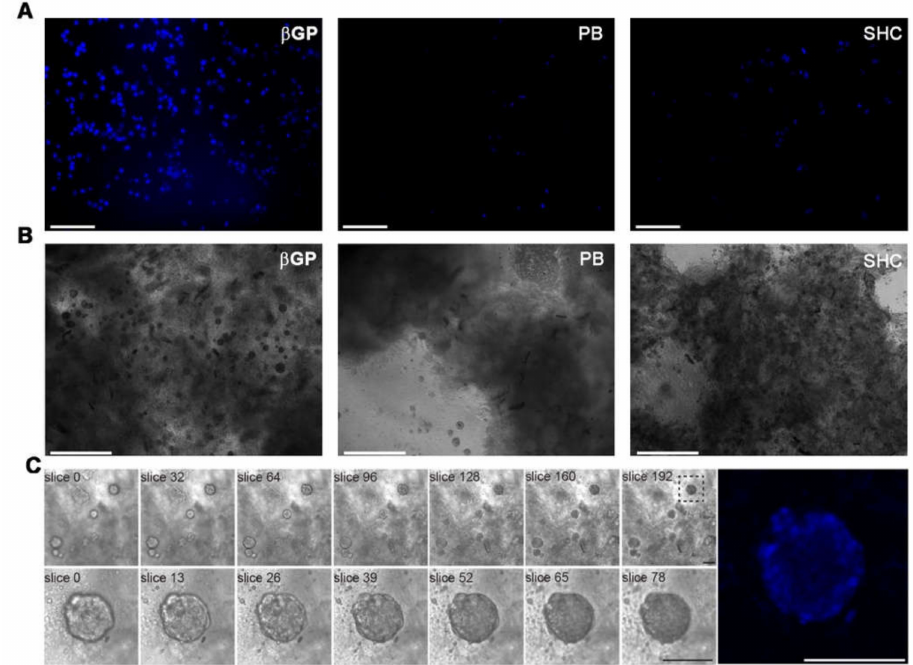
Figure 9. ( A ) Fluorescence microscopy investigation at 24 h of culture of cell-laden Ch-Pec hydrogels formed in the presence of different GAs. ( B ) Optical investigation of spheroids in Ch-Pec hydrogels after 21 days of culture. ( C ) Z-stack analysis at different magnifications of spheroids in Ch-Pec- β GP hydrogels after 21 days of culture (scale bars: 100 µ